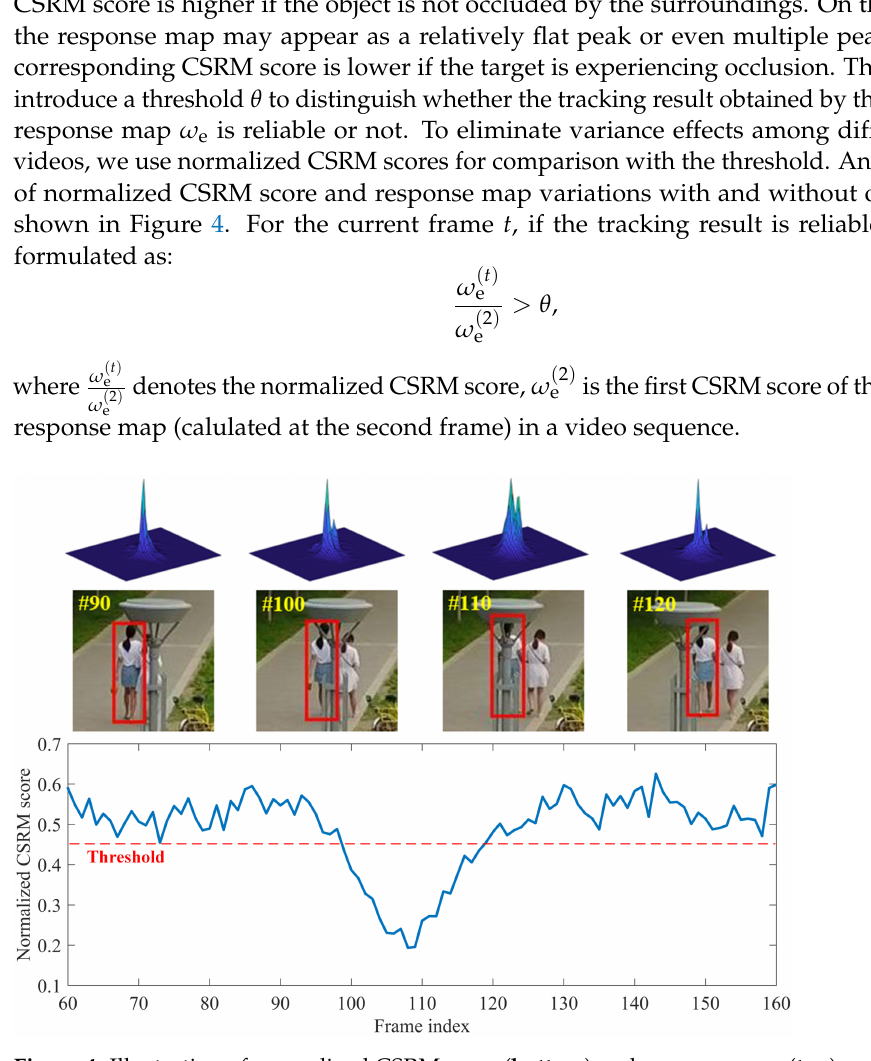
Figure 4. Illustration of normalized CSRM score ( bottom ) and response map ( top ) variations with and without occlusion. The example frames ( middle ) are from the VisDrone2018-SOT [46] benchmark. Severe occlusion occurs in frames 100 to 120, which brings a significant reduction of the normalized CSRM scores and causes multiple peaks in the response